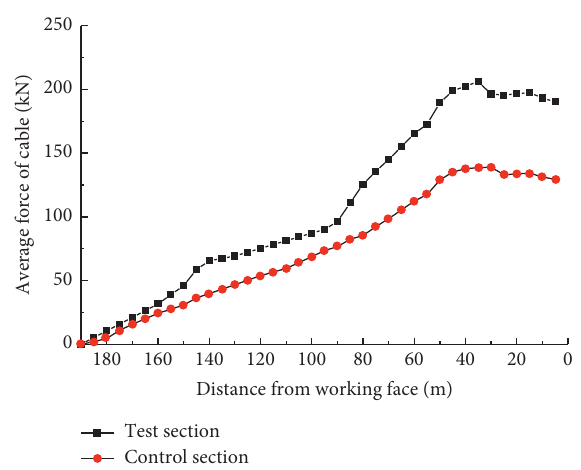
Figure 15: Average stress curve of anchor of surrounding rocks of solid coal side of roadway in control section and test